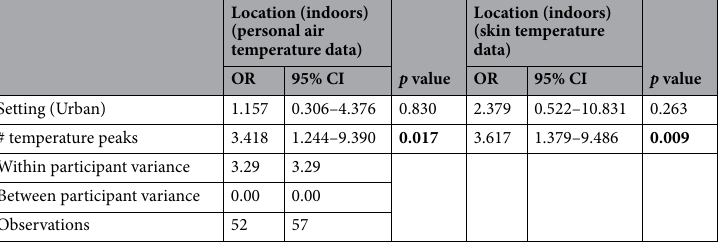
Table 5. Mixed effect models of participant location as a function of the setting, number of temperature peaks using either the personal air-, or skin-based number of temperature peaks from the sensor data. Statistically significant associations ( p -value < 0.05) are shown in